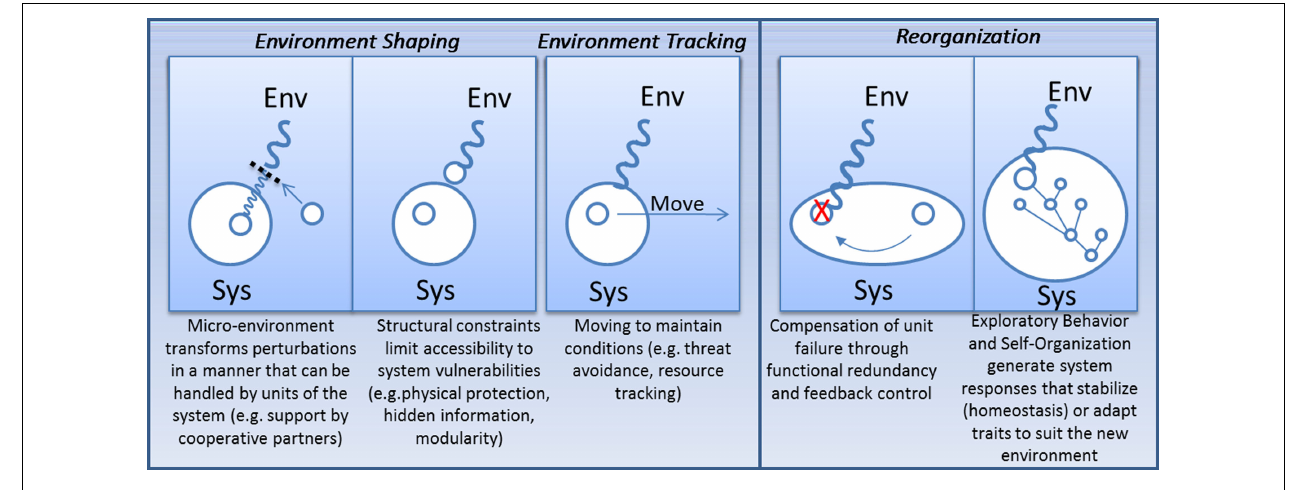
adapt system response to the environment in order to robustly maintain traits or adapt traits in order to preserve organism fitness.